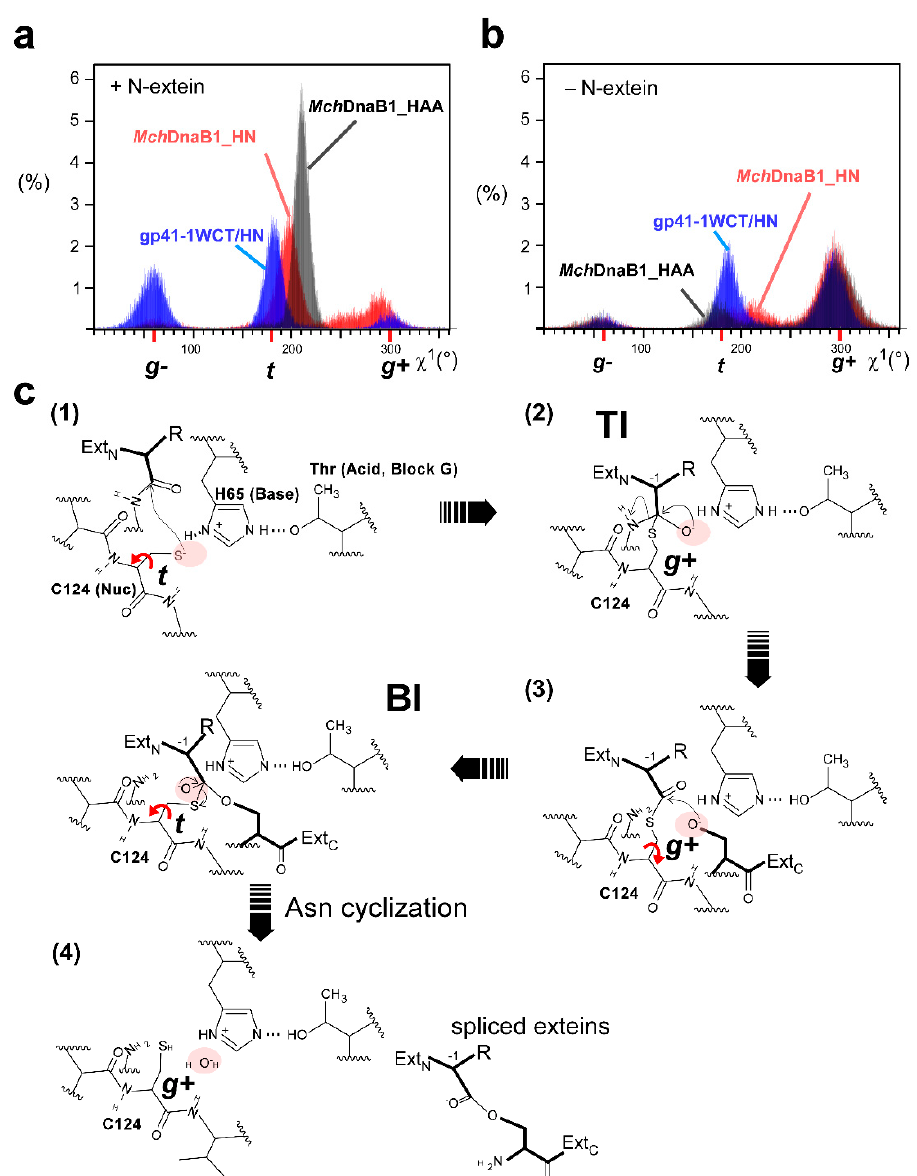
Figure 5. MD simulations and the proposed splicing steps by class 3 inteins. Histograms showing the distributions of the χ 1 angle for the cysteine residue in the WCT motif during the MD simulations of the two Mch DnaB1 intein variants and the engineered gp41-1 intein with WCT motif with the modeled N-extein ( a ) and without N-extein ( b ). Red, grey, and blue indicate the population data for Mch DnaB1_HN, Mch DnaB1_HAA, and gp41-1_WCT, respectively. ( c ) Proposed reaction steps for the protein-splicing mechanism by the class 3 intein. (1) High energy ground state before splicing with Cys124 in the unfavorable trans -like conformation. (2) Tetrahedral Intermediate (TI) status after rotation of Cys124 to the gauche + conformation to favor the nucleophilic attack. (3) Formation of the Branched Intermediate (BI) after N-cleavage. Rotation of Cys124 to the trans conformation will bring the thioester intermediate closer to the nucleophilic residue of the C-extein. Trans -esterification step via a tetrahedral intermediate. Rotation of Cys124 back to the gauche+ conformation. (4) Post-splicing status. Exteins are released from the intein. A red arrow indicates a rotational movement of Cys124. Pink shadows indicate possible locations for oxyanion holes. See main text for a more detailed description.